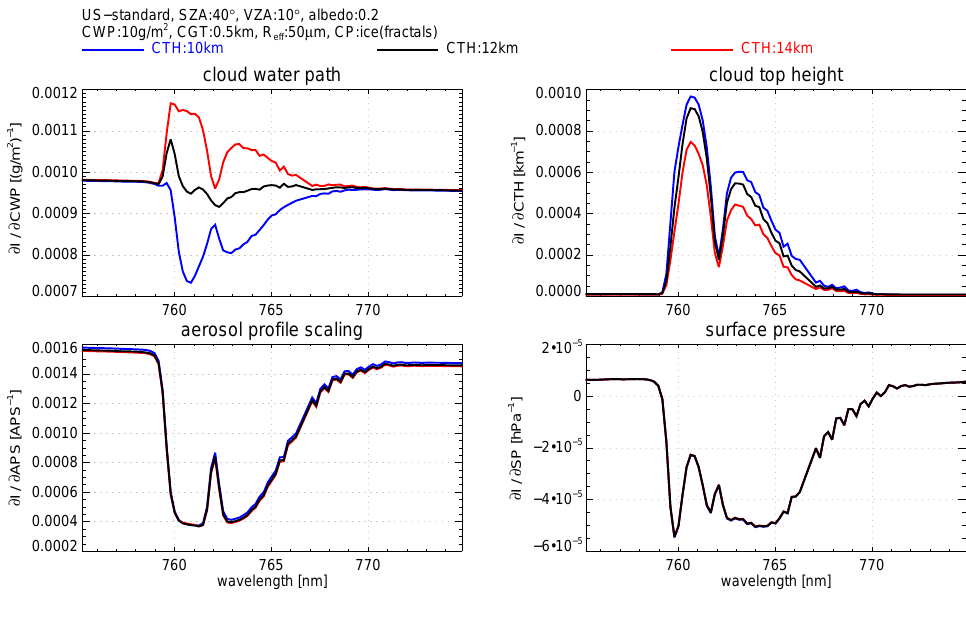
Fig. 2. Weighting functions in the O 2 fit window for three cloud scenarios based on a US-standard atmosphere including an optically thin ice cloud with a cloud top height of 10km (blue), 12km (black), and 14km (red): cloud water/ice path (top/left), cloud top height (top/right), scaling of the aerosol profile (bottom/left), and surface pressure (bottom/right). The weighting functions are calculated with the SCIATRAN 3.0 radiative transfer code and are folded with SCIAMACHY’s slit